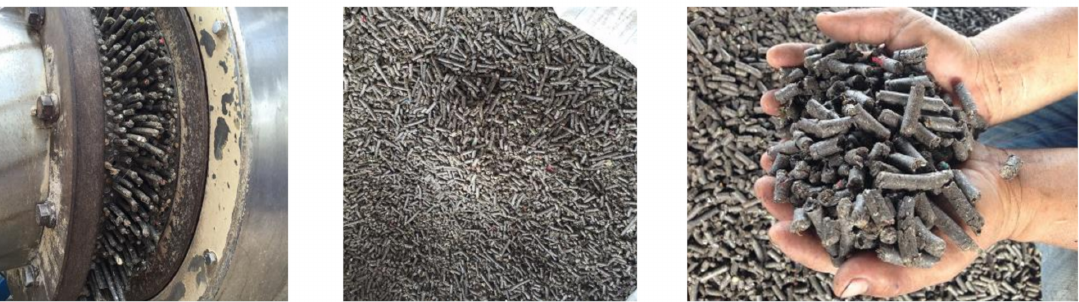
Figure 6. RDF pellets, densified-RDF or RDF-5 (Source of images: Suranaree University of Technology,